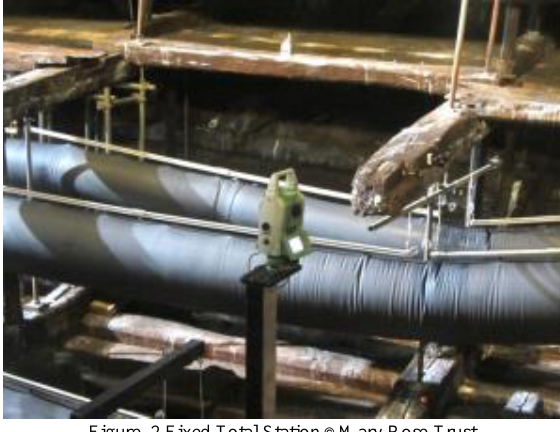
Figure. 2 Fixed Total Station ©Mary Rose